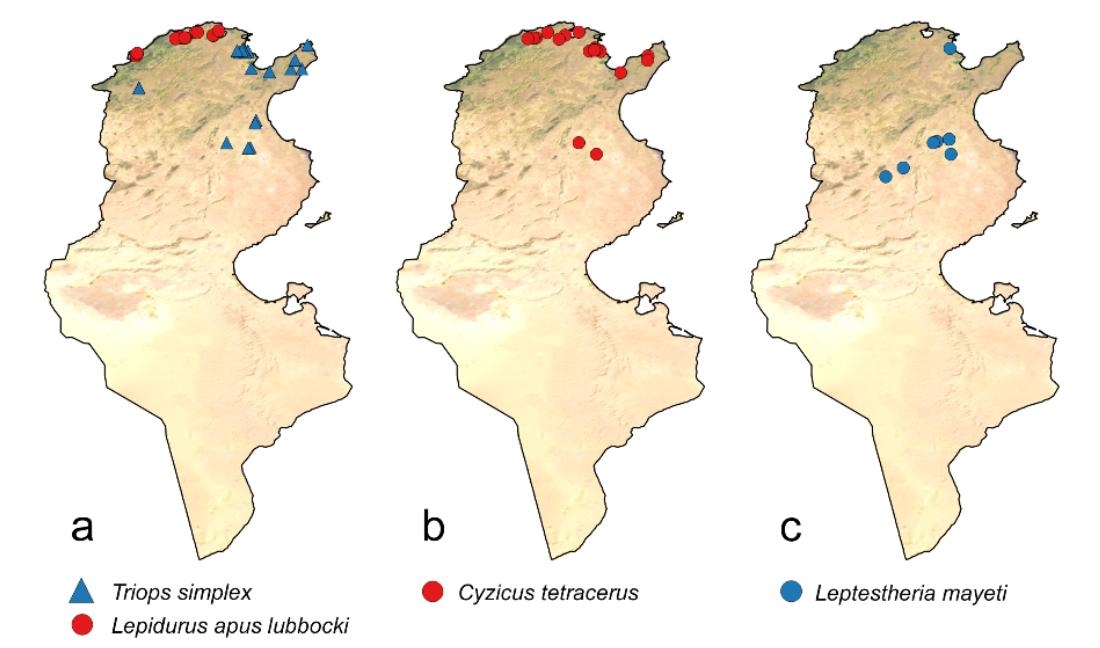
FIGURE 3. Distribution maps of selected Tunisian large branchiopod species based on present